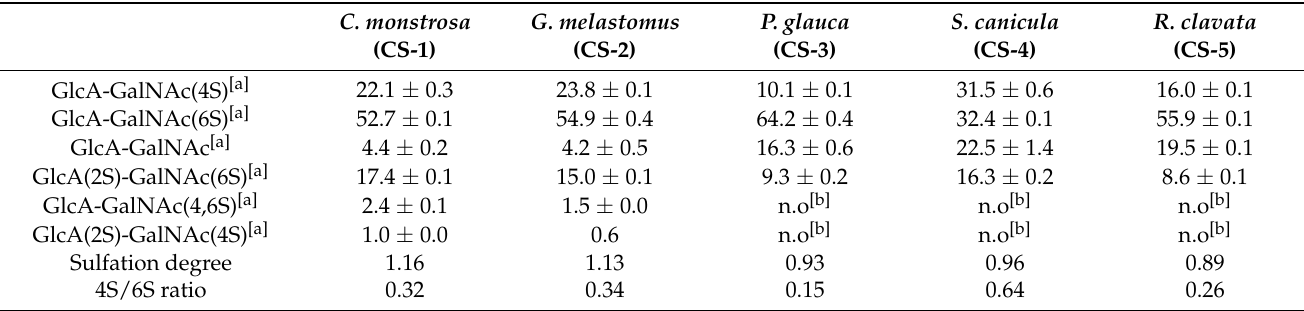
Table 1. Disaccharide composition and corresponding sulfation pattern of natural polysaccharides. Sulfation degree: average number of sulfate residues per disaccharide unit.